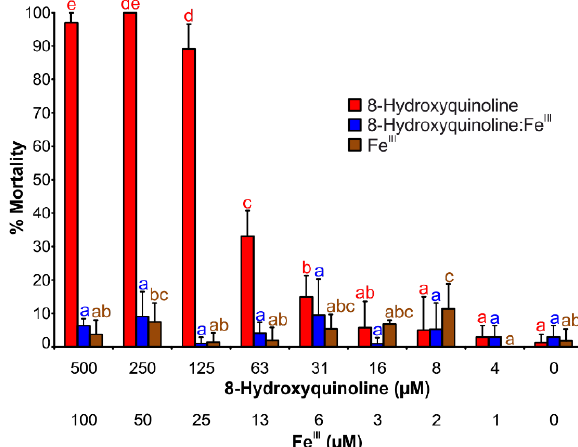
Figure 4. Brine shrimp ( Artemia salina L.) mortality caused by 8HQ in free form and as Fe III − 8HQ complexes. The upper scale designates the concentration of 8HQ, the lower one the concentration of iron (III) in the tested solution. The bars represent means of eight replicates ( ± S.D.). The different significance levels were determined by Duncan’s post hoc test (95%) and are indicated by the letters a–e above the error bars.